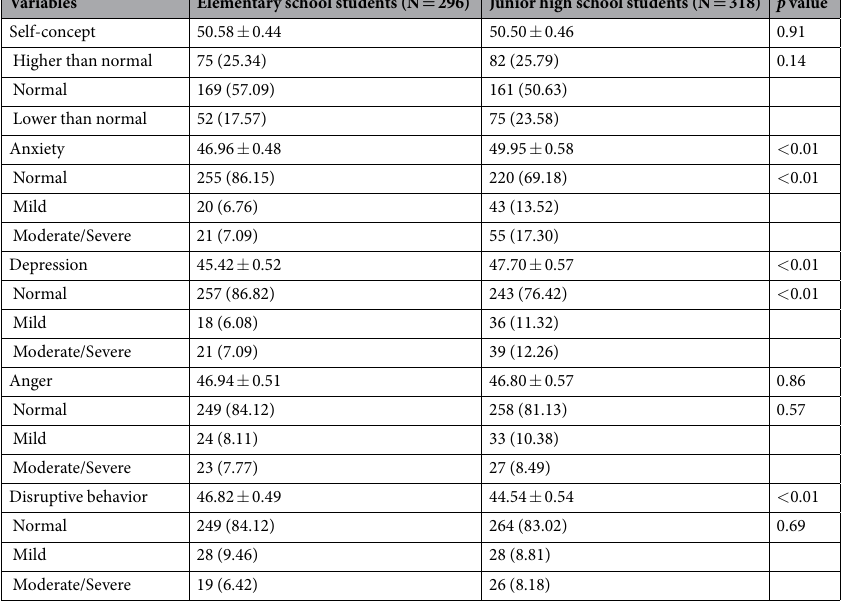
Table 2. Psychological characteristics stratified by educational